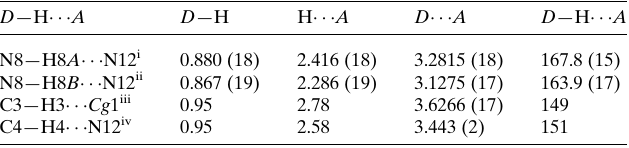
Table 1 Hydrogen-bond geometry (A˚ , (cid:5) ).